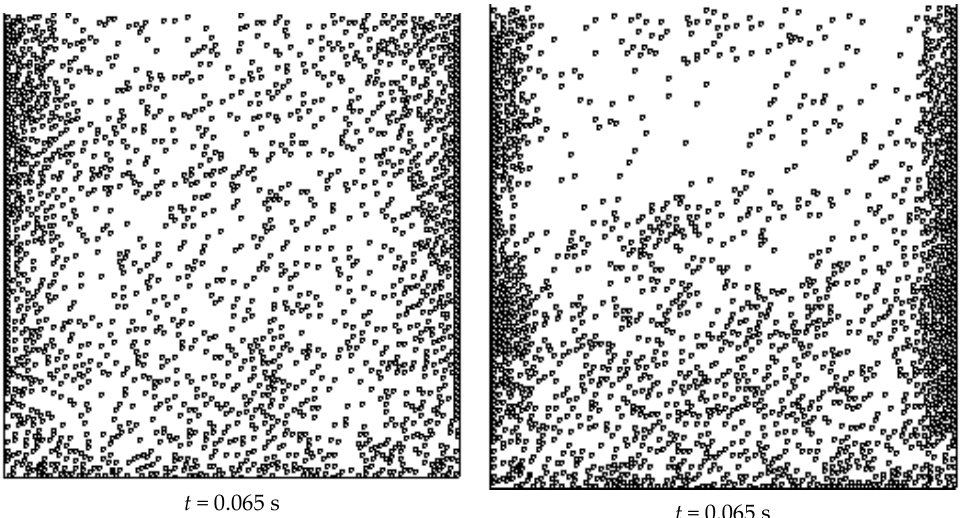
Figure 1. Particle location.